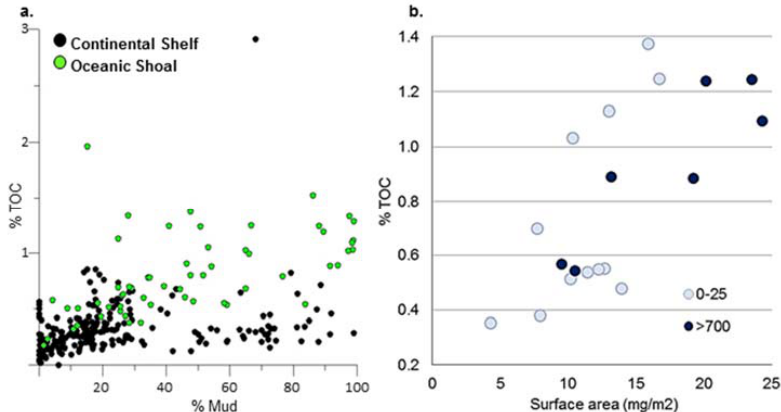
Figure 11. Total carbon dioxide porewater pool concentration (0–2 cm) versus porosity (0–2cm) of the samples collected on the Australian Shelf between October 2007 to May 2013 (see Table 1 in [39] for survey details). The yellow triangles pertain to pockmarked sediment in the Oceanic Shoals AMP survey